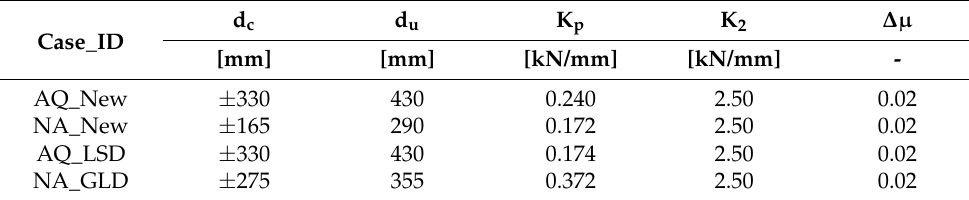
Table 4. Over-stroke parameters of the isolation